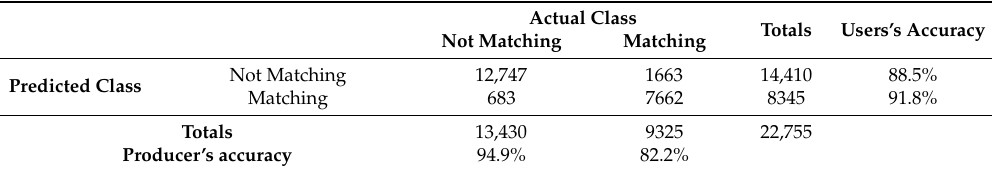
Table 4. Confusion matrix for tree matching using synthetic validation data.